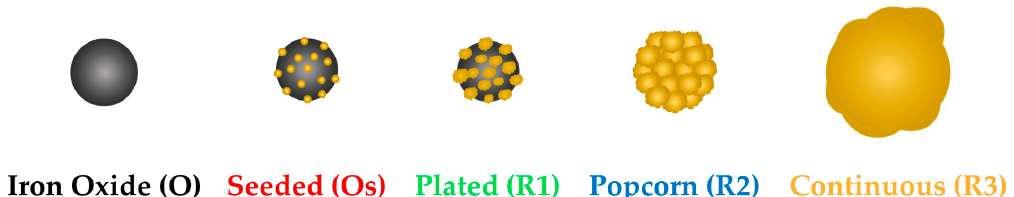
Figure 1. Illustration of the various forms and thicknesses of magnetic-plasmonic nanoparticles studied for this paper. From left, the (3-aminopropyl) triethoxysilane (APTES) functionalized iron oxide (Fe 3 O 4 ), called O throughout. Next, the Fe 3 O 4 nanoparticles functionalized with gold seeds, Os. Middle, the Fe 3 O 4 –Au gold-plated nanoparticle after one gold reduction, R1. R2 is the magnetic- plasmonic nanoparticle after two gold reductions and, lastly, R3, after three gold reductions. Reproduced with permission from [28]; Copyright The Royal Society of Chemistry, 2020.